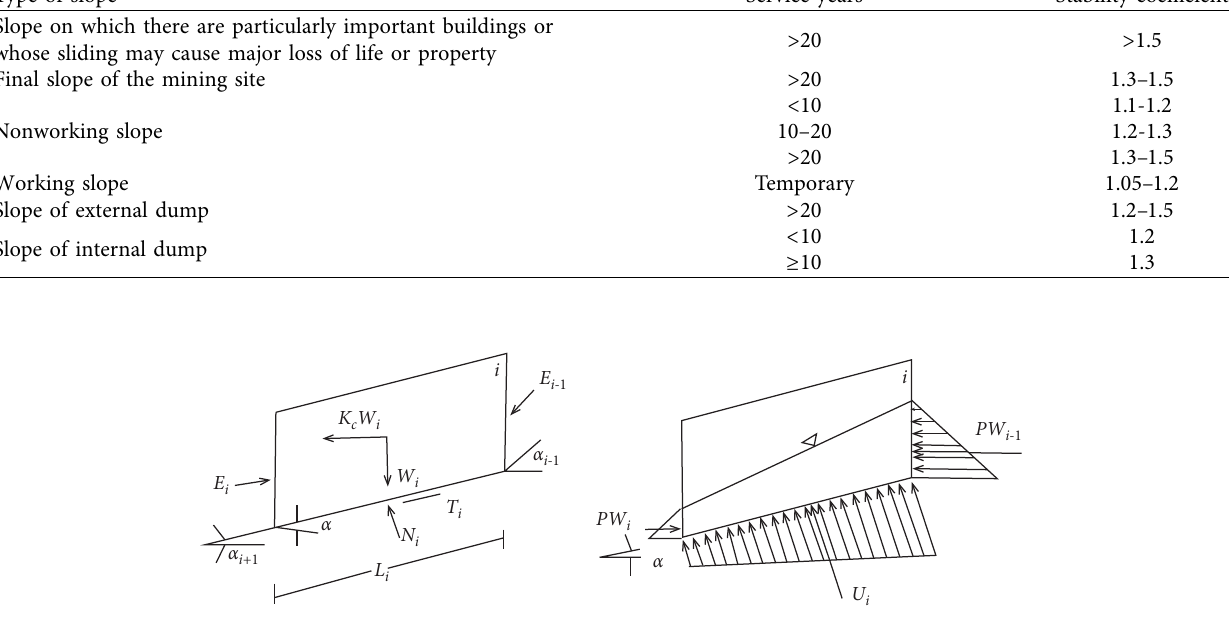
Figure 15: Sketch maps of force imposed on the slide block i .